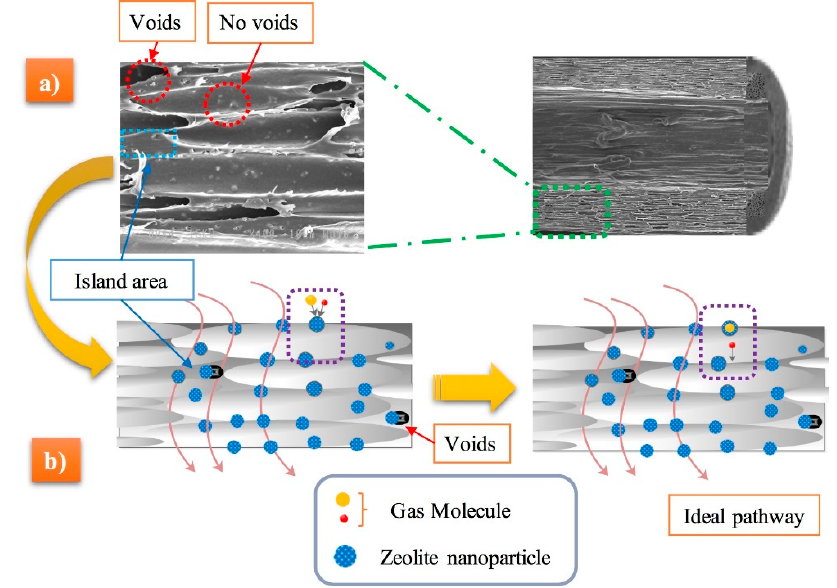
Figure 15. ( a ) Scanning electron microscopy (SEM) of the selected MMFM15 membranes and ( b ) schematic representation of the gas molecule diffusion pathways.